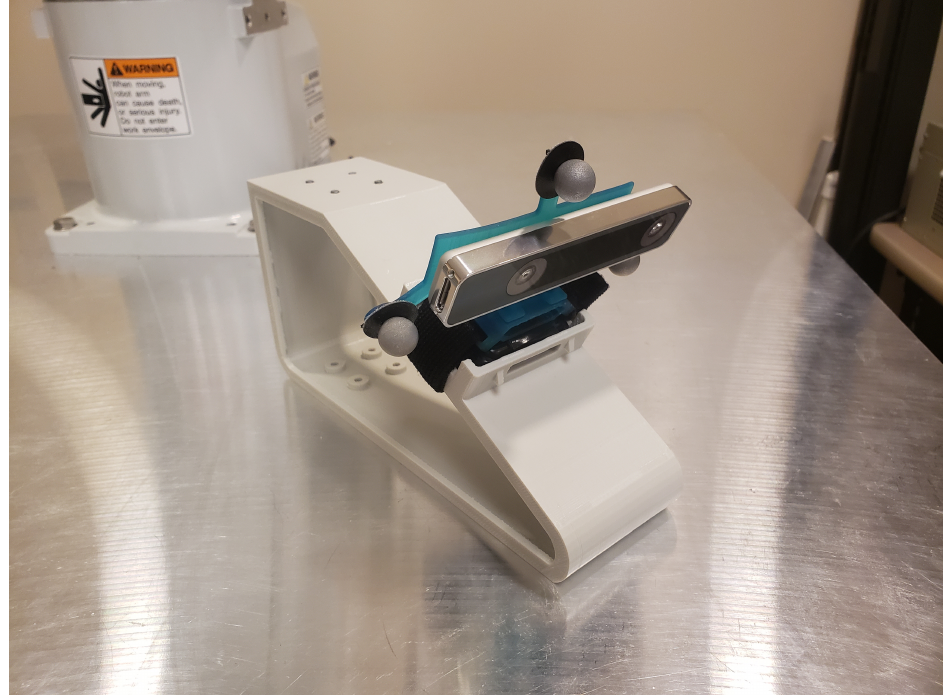
Figure 4. Jig simulating a human foot used to attach the Intel T265 camera to Epson C3 robotic